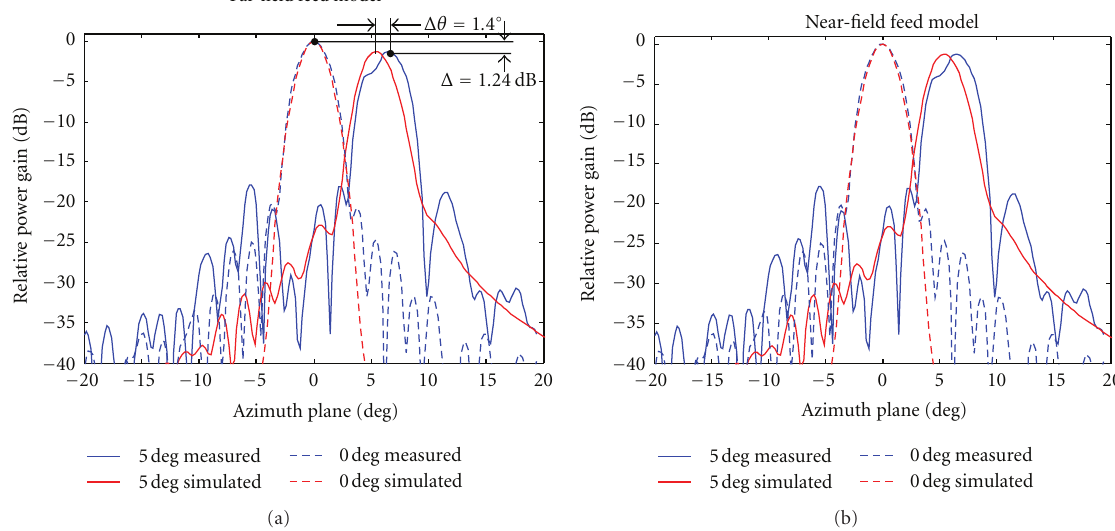
Figure 4: Measured and simulated radiation patterns of the dual reflector antenna with reflectarray subreflector in the azimuth plane at 94GHz, using (a) far-field and (b) near-field models of the feed horn. (From [21] © 2009 IEEE).